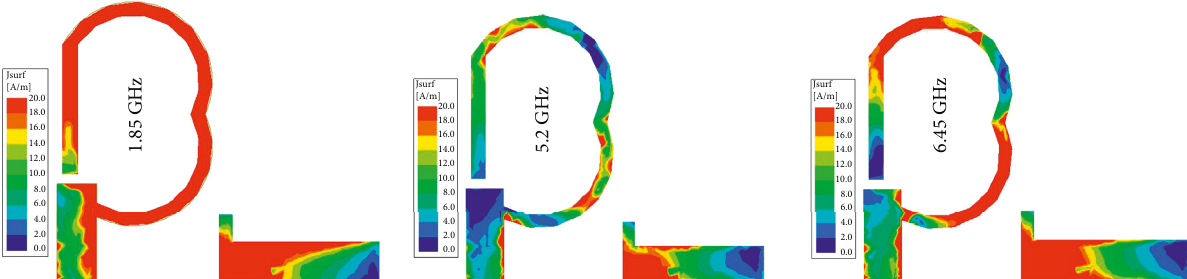
Figure 6: The surface current distribution of the OBS antenna.